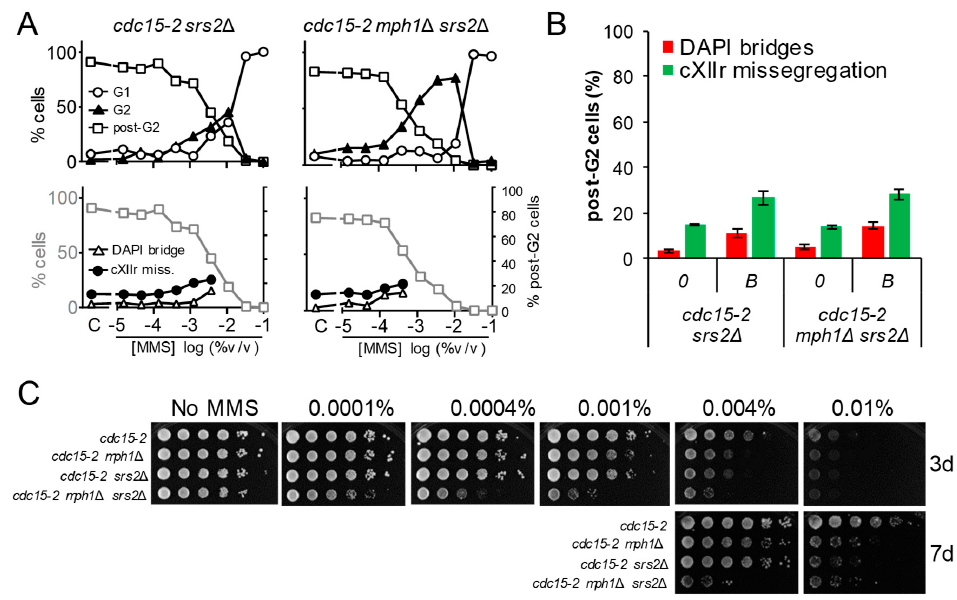
Figure 4. The elimination of the 3 ′ → 5 ′ helicase Srs2 exacerbates the MMS ‐ driven G2 block of mph1 Δ . ( A ) MMS dose ‐ response curves of the FM588 srs2 Δ and srs2 Δ mph1 Δ mutant derivatives. ( B ) DAPI ‐ bridges and cXIIr missegregation of three independent experiments without (“0”) or with borderline (“ B ”) MMS (mean ± SEM). B was 0.004% v/v for srs2 Δ and 0.0004% v/v for srs2 Δ mph1 Δ . (C) Long ‐ term survival (spotting assay) for the referred mutants under increasing doses of MMS. Note the negative synergism between srs2 Δ and mph1 Δ with regards to the short ‐ term G2 block and long ‐ term